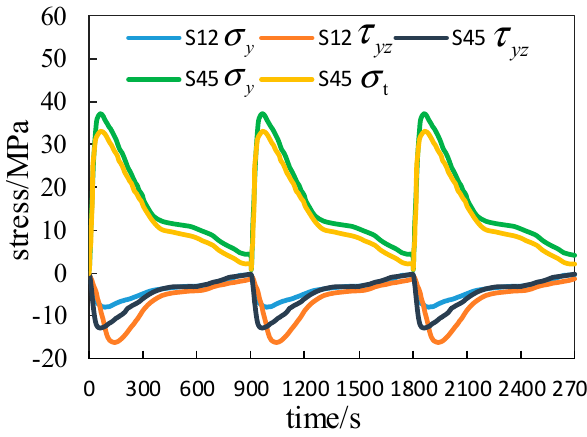
Figure 8. Stress distribution at points A and B.